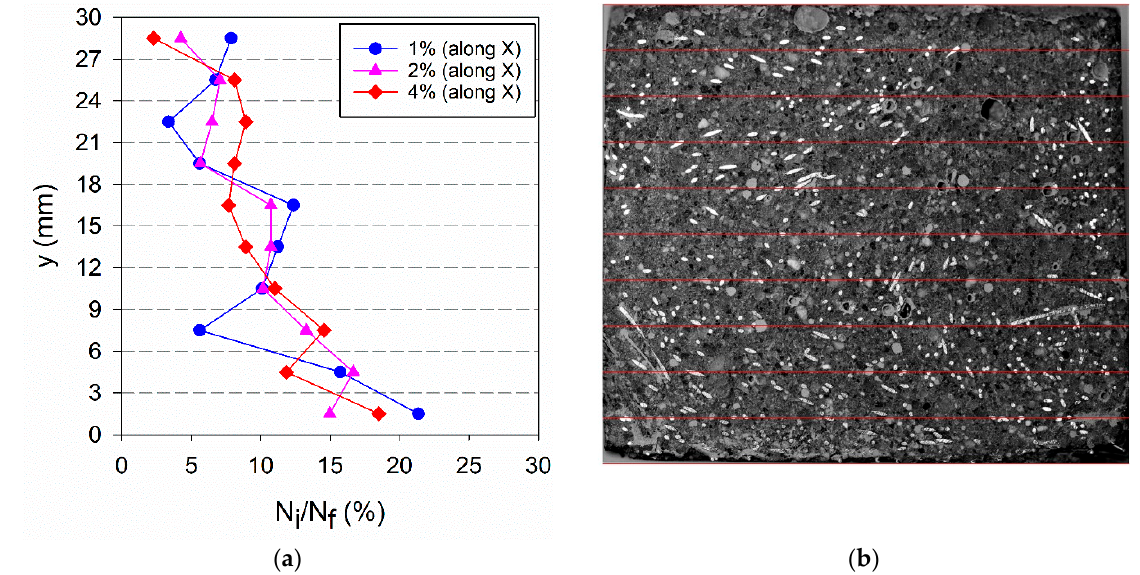
Figure 17. ( a ) Fibre distribution along the plate thickness for HR_i specimens ( b ) image of HR_4% along X-direction.